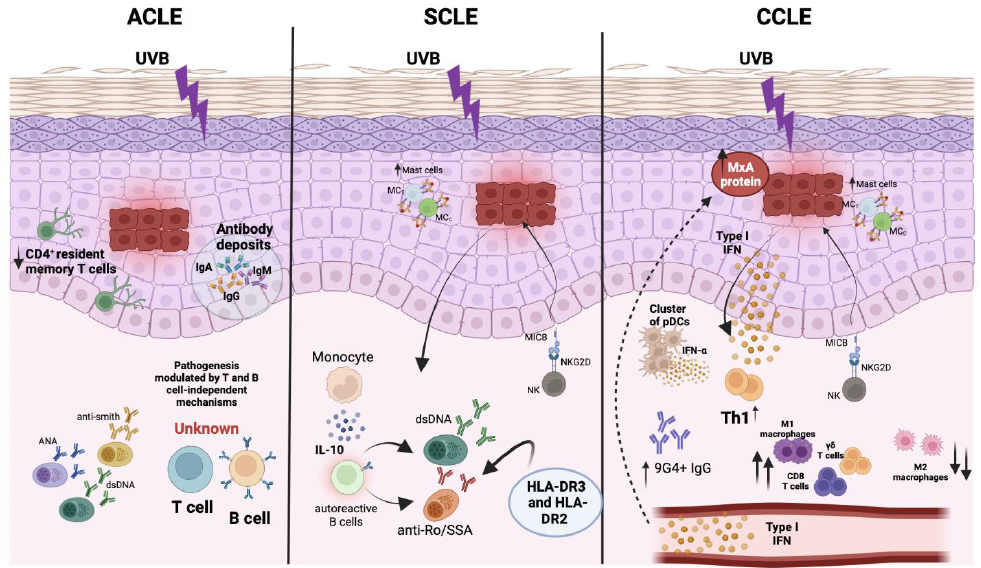
Figure 1. The immune cells are involved in the induction of CLE. The figure shows the main immunological mechanisms associated with the induction of ACLE (left panel), SCLE (middle panel), and CCLE (right panel) in the presence of a stimulus with UVB light. The arrows pointing up symbolize an increase, while the arrow pointing down represents a